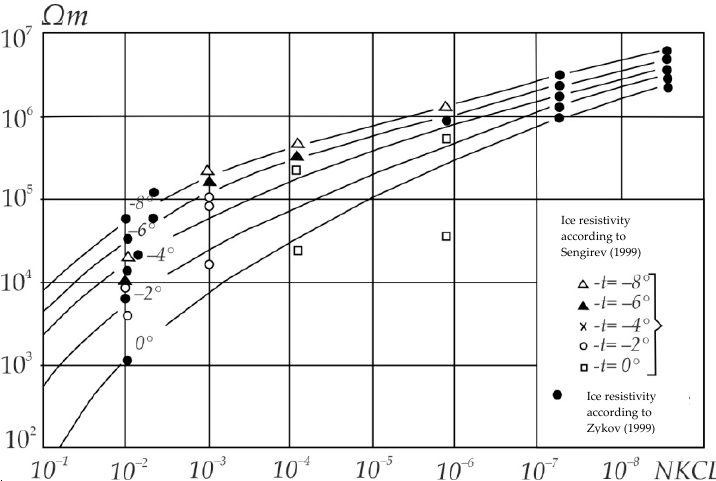
(Figure 3). (Figure 3). (Figure 3).